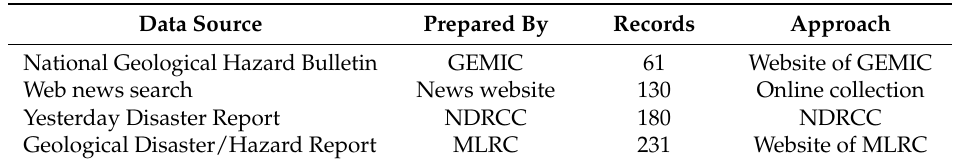
Table 1. Data source of landslide casualties database of